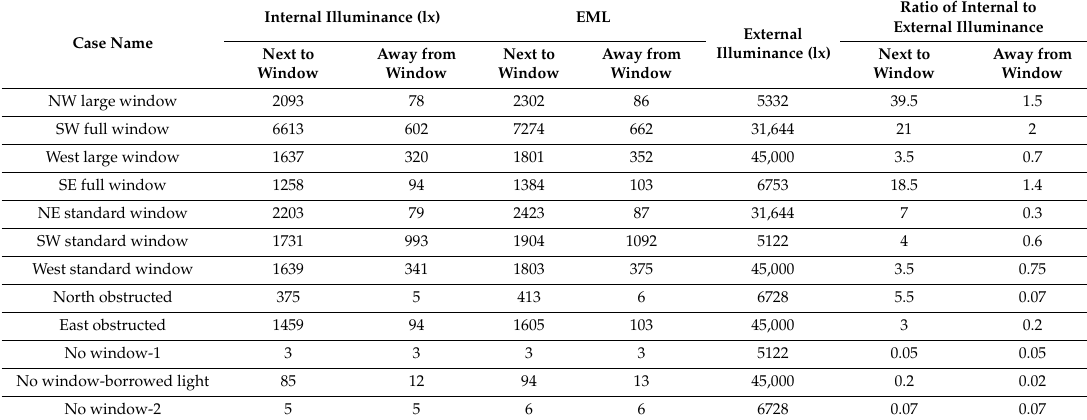
Table 2. Measured daylight